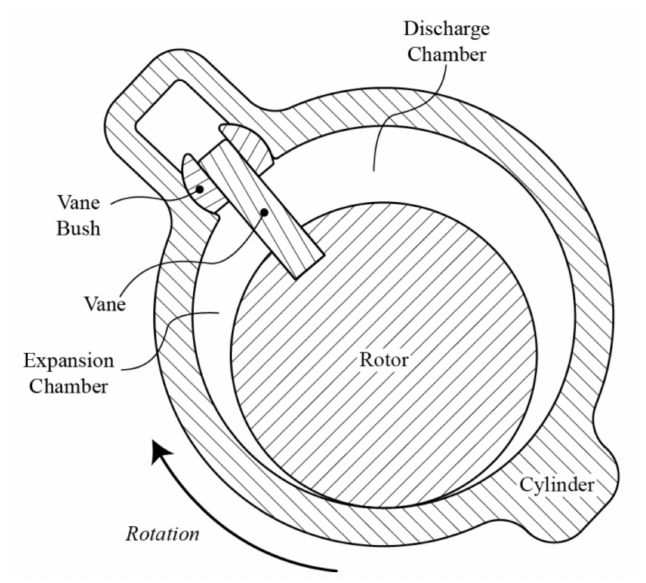
Figure 1. Revolving vane